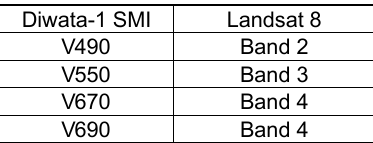
Table 2: The value of central wavelengths of Diwata-1 SMI images used in the study, and their Landsat 8 counterparts.